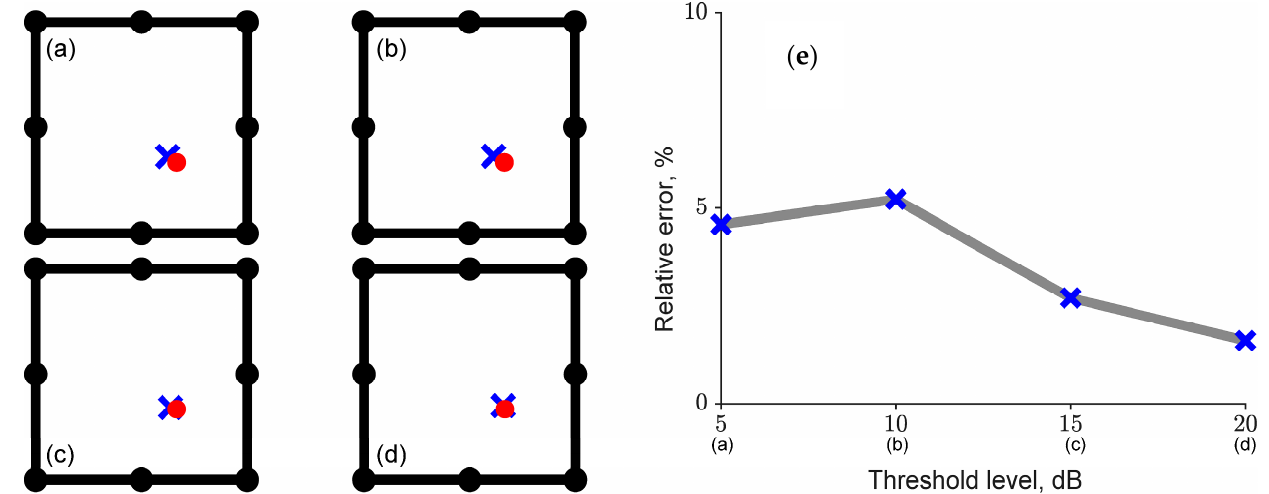
Figure 7. Results of elastic wave numerical experiments using various thresholds to obtain TOA. Estimated positions are denoted as ( a – d ) at threshold levels of 5, 10, 15, and 20 dB, respectively. The black dots are for sensor positions, while red dots represent crack positions. The blue cross mark (x) denotes the estimated crack position. The relative error for noise is shown in ( e